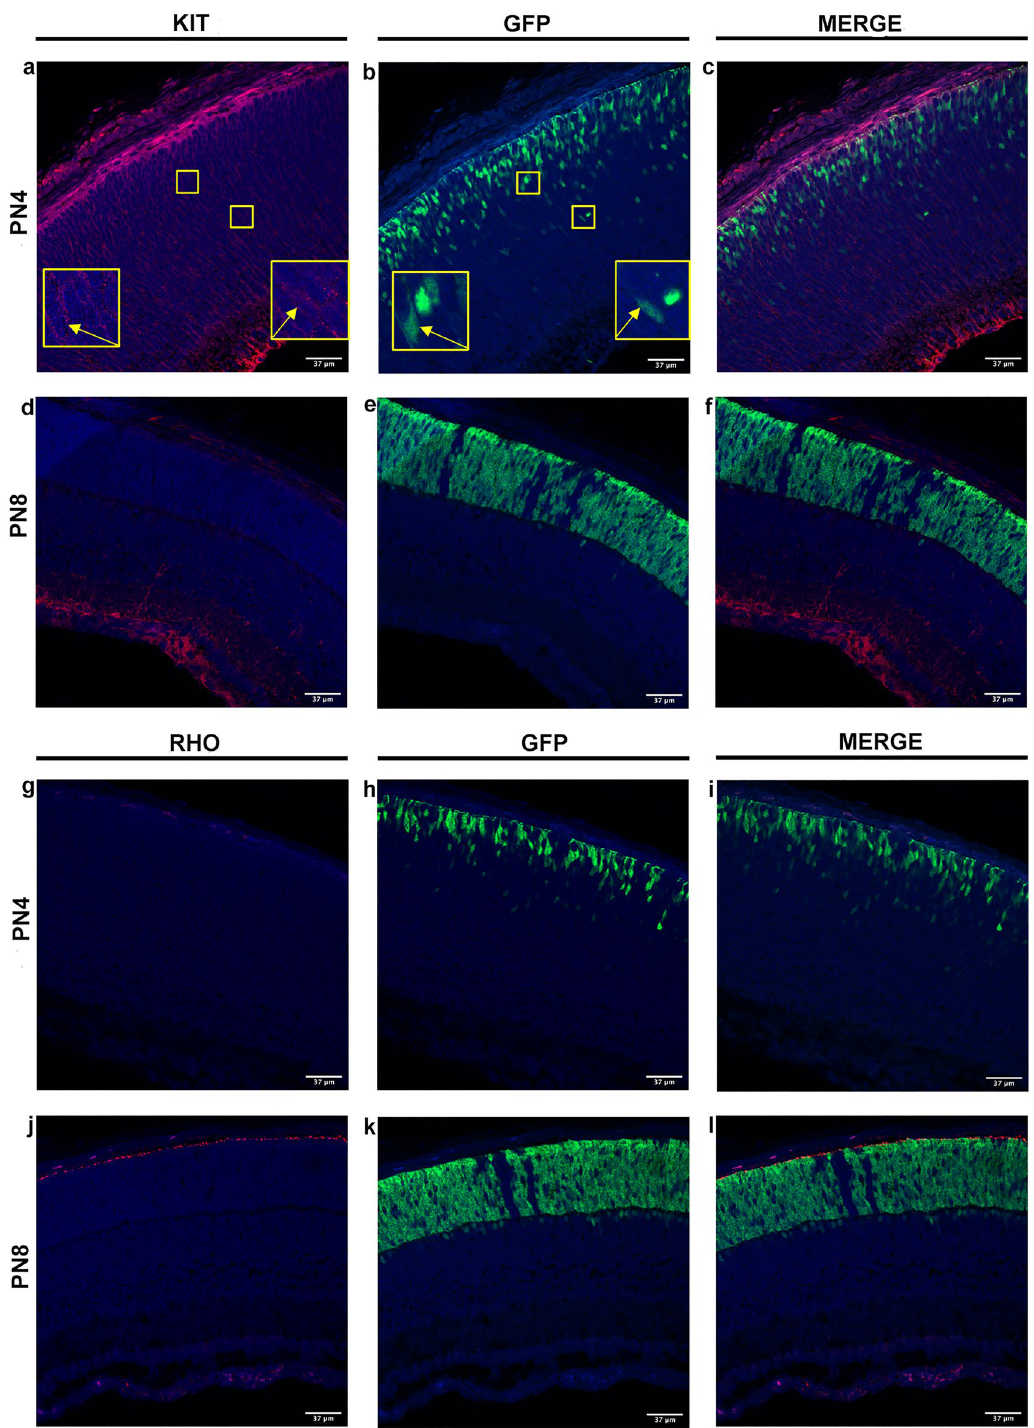
Figure 2. Confocal immunofluorescence imaging of c-Kit and Rho in PN4 and PN8 NRL-GFP + retina. ( a – f ) Immunostaining for c-Kit at PN4 ( a ) and PN8 ( d ). GFP expression at PN4 ( b ) and PN8 ( e ). Merged images at PN4 ( c ) and PN8 ( f ). Insets in panels ( a ) and ( b ) show a magnification of GFP + cell labelling positive for c-Kit. ( g – l ) Rho immunostaining at PN4 ( g ) and PN8 ( j ). GFP signal at PN4 ( h ) and PN8 ( k ). Merged images at PN4 ( i ) and PN8 ( l ). The calibration bar corresponds to 37